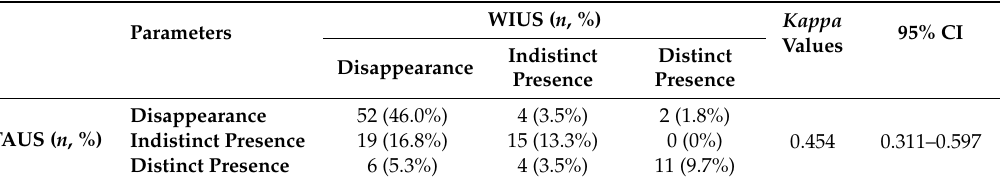
Table3. ComparisonbetweenTAUSandWIUSforimagingfindingsrelatedtodetailedwallstratification in submucosal and mucosal layers (n =